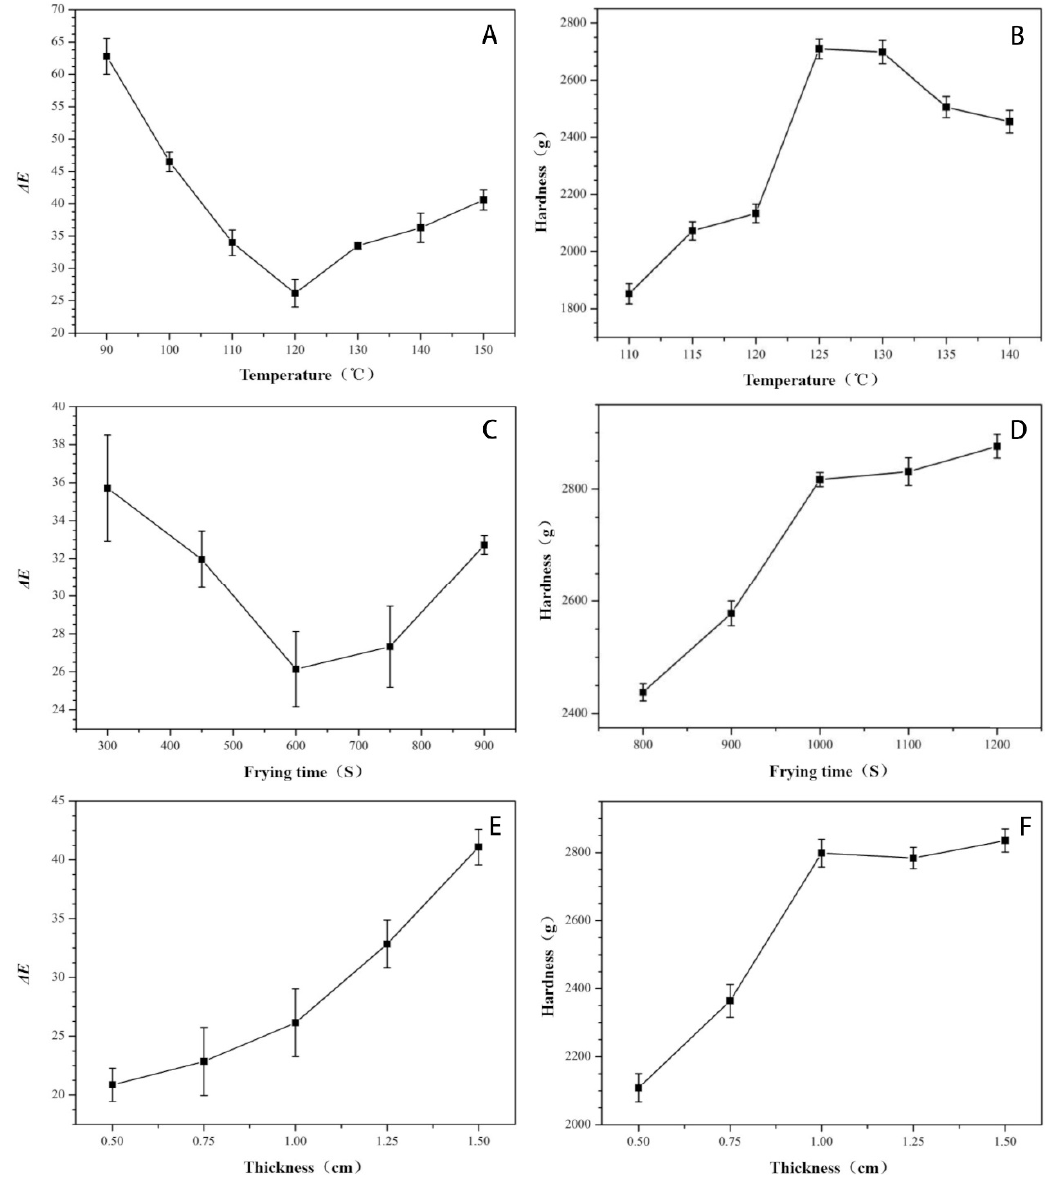
Figure 1. Effect of different factors on the textural quality of the Raphanus sativus -added surimi cubes (( A ) the influence of temperature on Δ E , ( B ) the influence of temperature on hardness, ( C ) the influence of frying time on Δ E ; ( D ) the influence of frying time on hardness; ( E ) the influence of thickness on Δ E ; and ( F ) the influence of thickness on hardness).